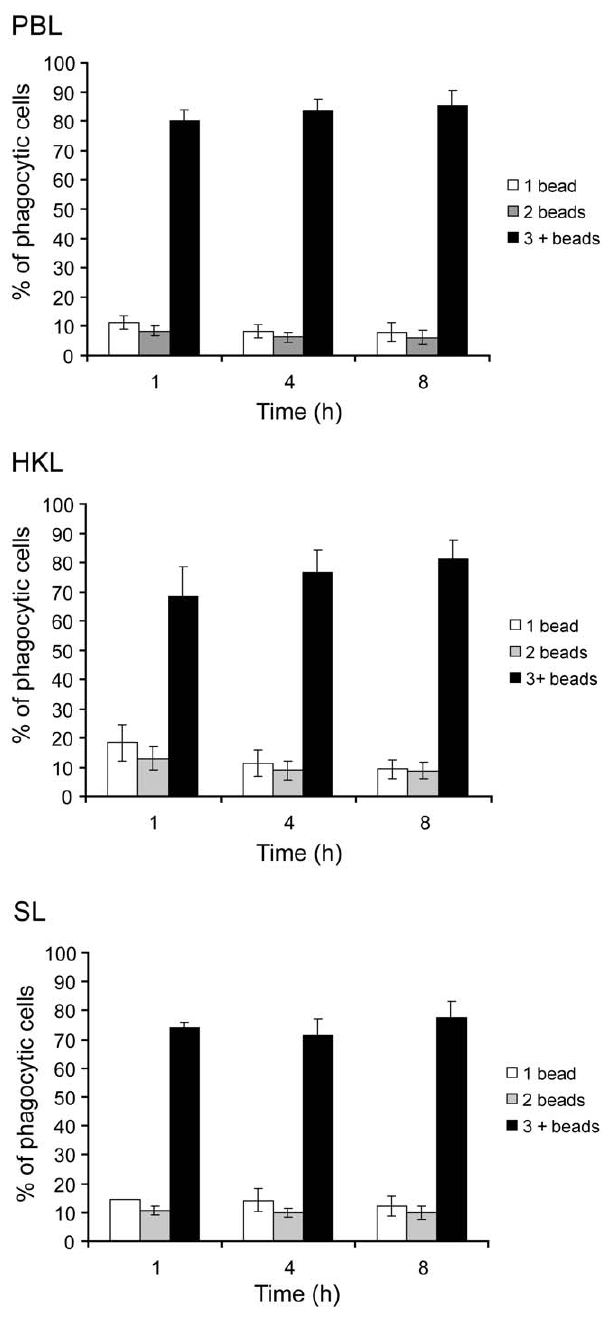
Figure 6. Phagocytic cells ingest beads rapidly. Proportions of phagocytic cells with various numbers of ingested beads in PBL, HKL and SL after incubation with fluorescent beads (1 m m) for 1, 4 or 8 h detected by flow cytometry (mean, bars indicate SD, N=6 in all analysis except for SL 4 h where N=5).